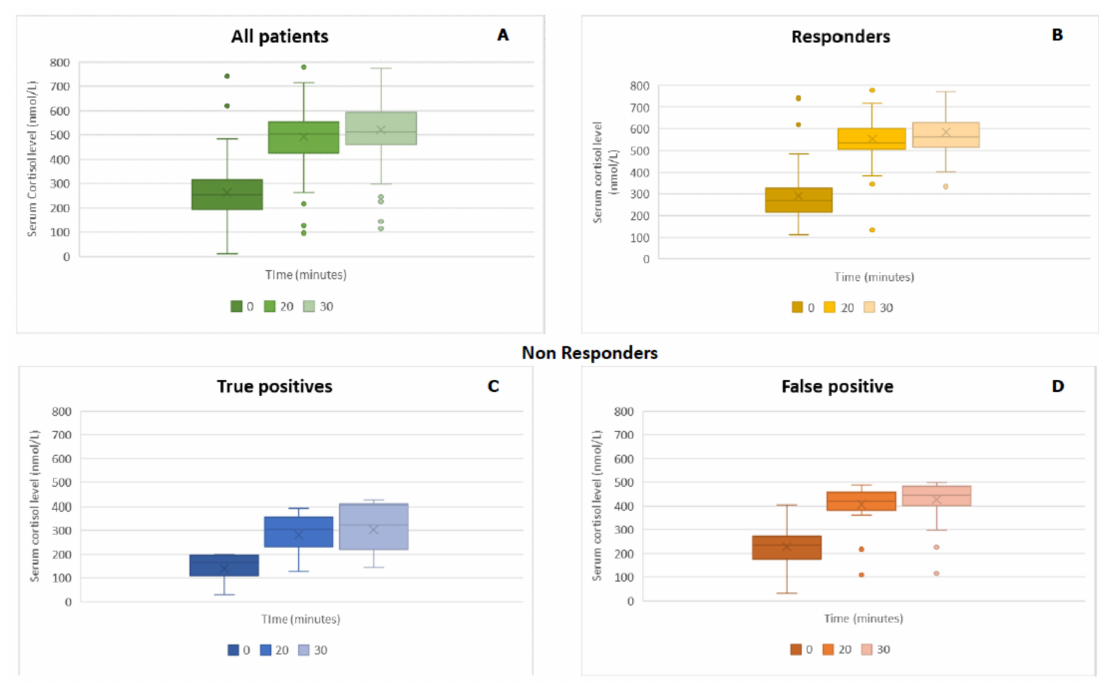
Figure 1. Serum cortisol values at 0, 20, and 30 minutes after corticotropin (ACTH) administration in ( A ) all patients; ( B ) the responder group (cortisol peak > 500 nmol / L); ( C ) true positive (cortisol peak